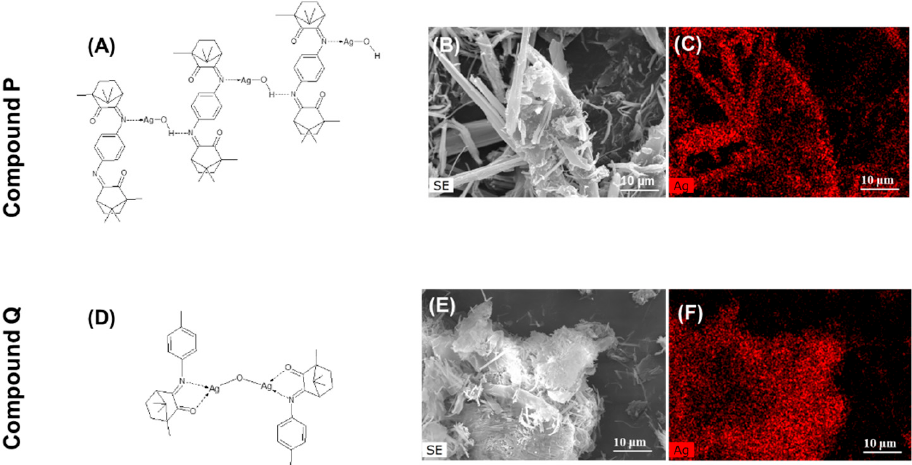
Figure 2. Physicochemical characterization of compounds P and Q; schematic structural arrangement ( A , D ), SEM micrographs ( B , E ), and EDS map of silver ( C , F ) of compound P and Q, respec- tively.